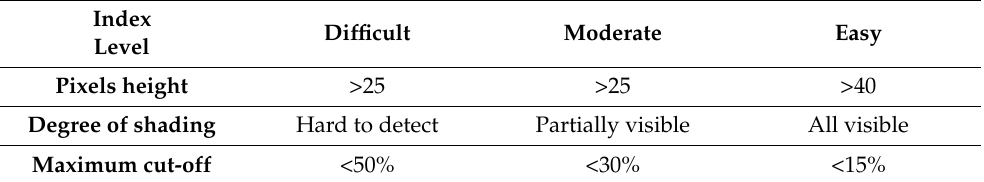
Table 3. KITTI 3D objection detection difficulty grading standard.